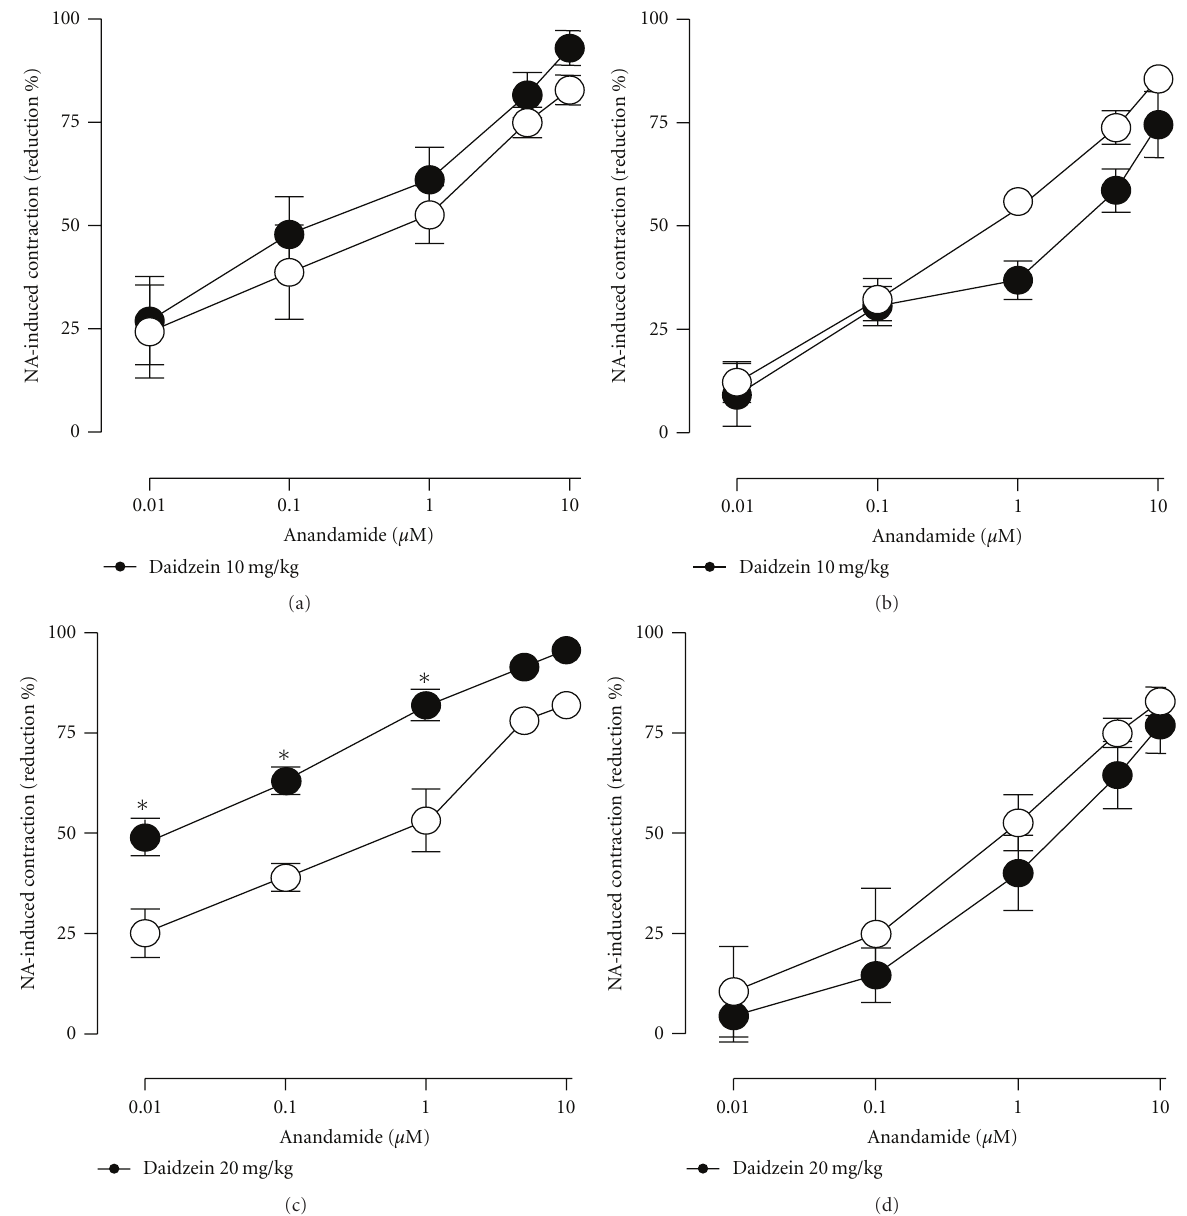
Figure 2: E ff ects of 3-day oral administration of either 10 mg/kg or 20mg/kg daidzein (filled circles) on anandamide-induced reductions of contractile responses to NA in mesenteric vascular beds isolated from female (a) and (c) as well as male (b) and (d) rats. Vehicles are depicted in open circles. ∗ P < 0 . 05 when treatment with daidzein was compared to the corresponding